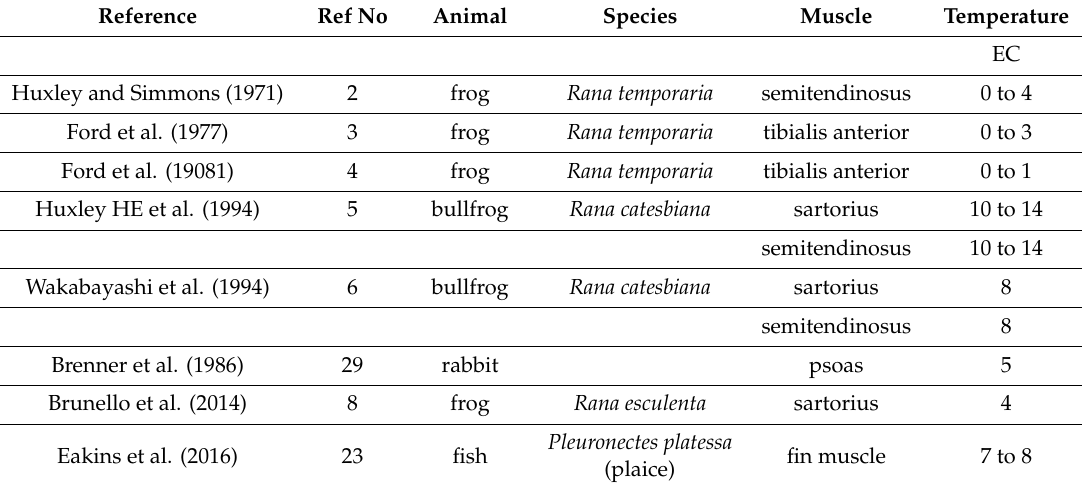
Table A1. Comparison of sources of the observations used here.